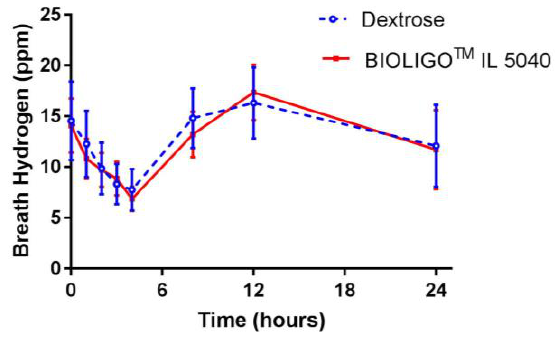
Figure 2. Breath hydrogen (ppm) measured over 24 h (Study 1); Data are mean ± SEM.